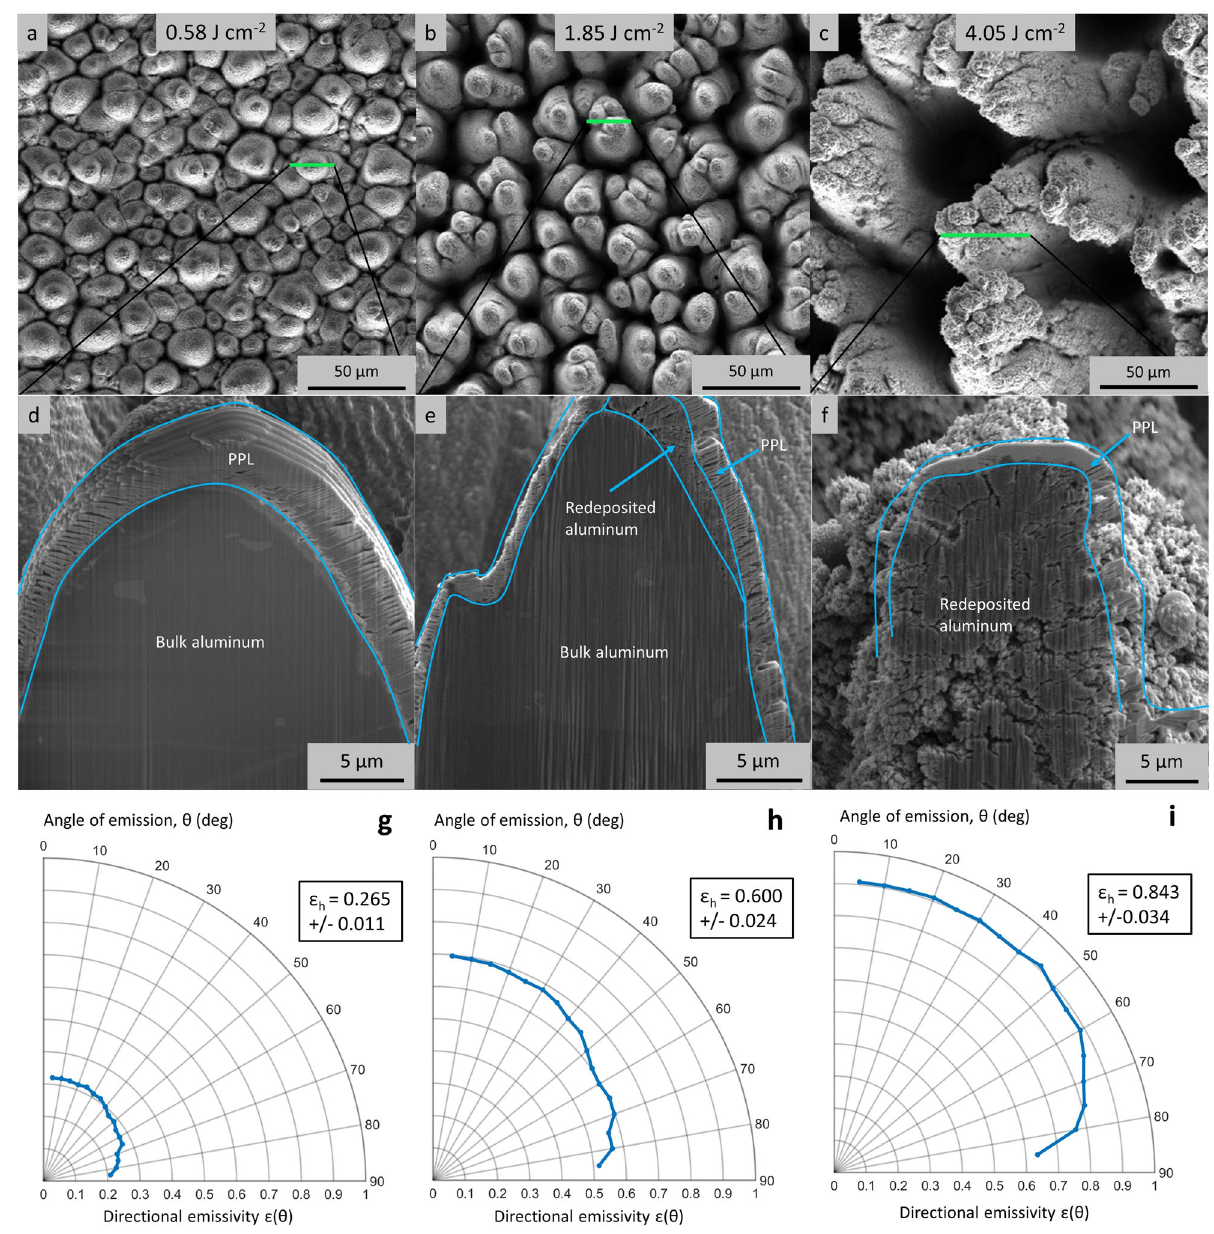
Fig. 2 Surface and subsurface images, and emissivity of samples produced in nitrogen environment. a – c SEM images of samples produced at the fl uence speci fi ed in the gray box in the top middle of each image for a constant pulse count of 1865. d – f SEM images of FIB cross-sectioned mounds to show subsurface structure of the corresponding sample in a – c . The green lines in a – c indicate the location of the corresponding cross section in d – f . PPL stands for protective platinum layer that is deposited before the cross-sectioning. Blue lines are included to better distinguish the transition between layers with different microstructure or material composition. g – i The corresponding directional and hemispherical emissivity of each sample in the same